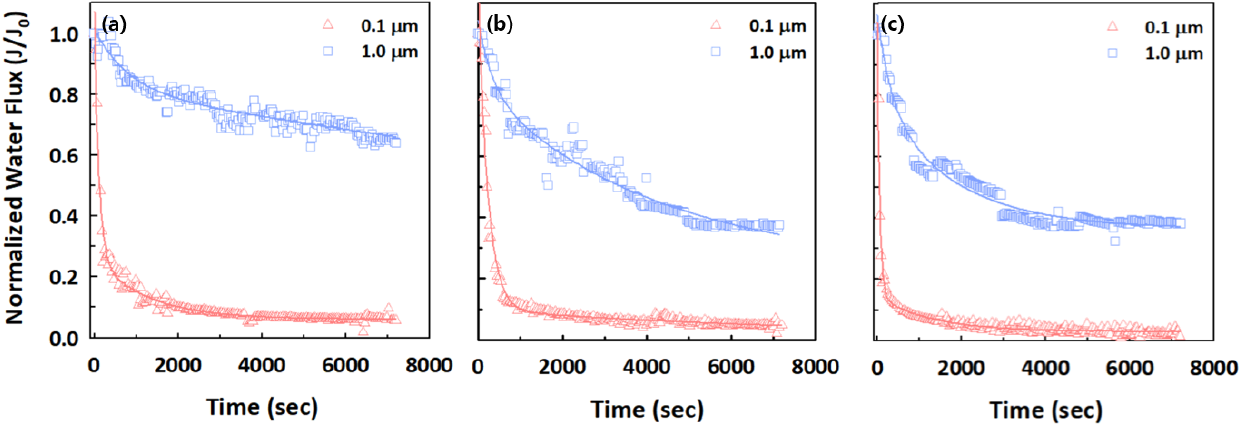
Figure 4. Normalized water flux decline of 0.1 and 1.0 μm PS microplastics for ( a ) Synder, ( b ) SteriLUX ® , and ( c ) Anodisc membranes. Table 3. R 2 values corresponding to the fouling mechanisms estimated by the blocking model for 0.1 and 1.0 μm PS microplastics during the three different membrane filtrations. Complete Standard Pore Intermediate Cake PS Membrane Pore Blocking Blocking Pore Blocking Microplastic